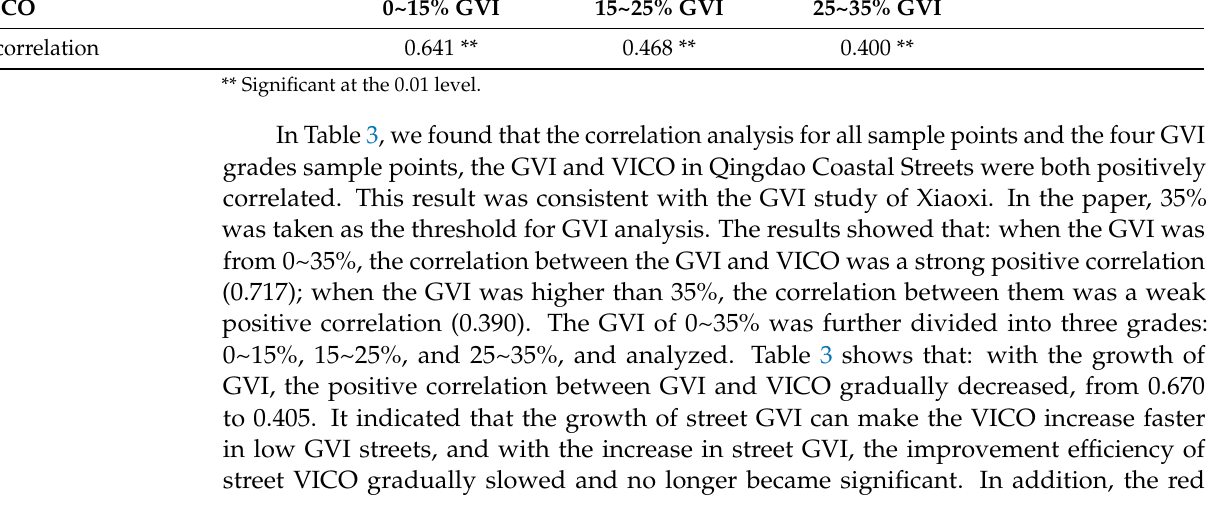
Taipingjiao 1st Road, and Taipingjiao 4th Road, high VICO sample points had the highest